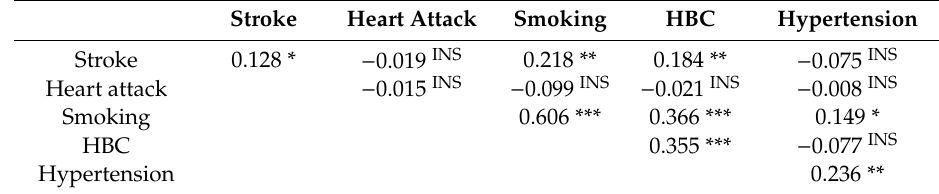
Table 2. Global univariate and bivariate spatial autocorrelation association between the age–sex standardised incidence rates of CVDs and identified risk factors for all